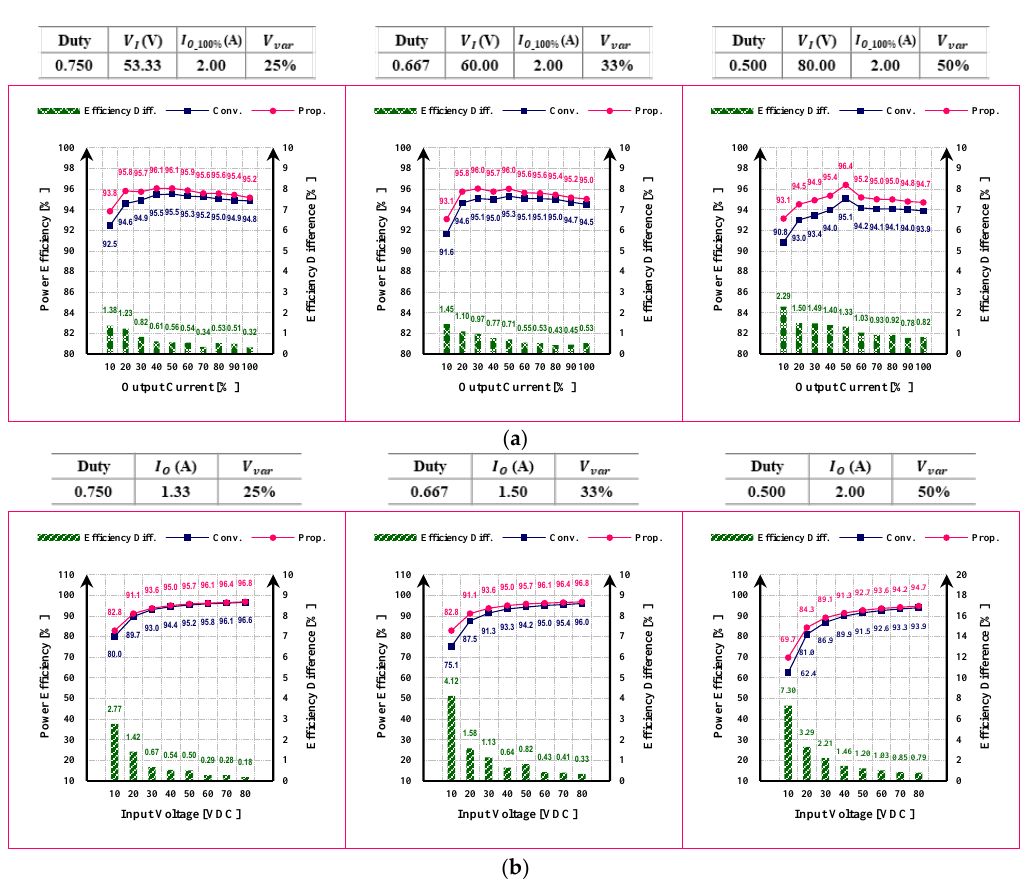
Figure 9. Power efficiency comparison of the buck topology: ( a ) CV mode; ( b ) CC mode.